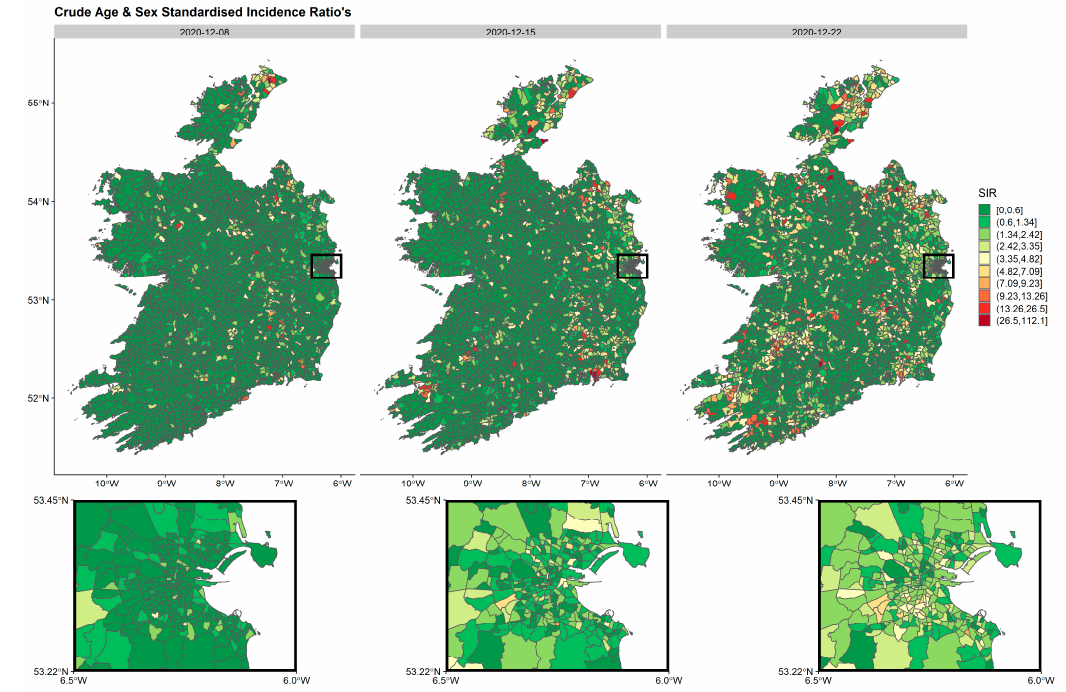
Figure 2. Age- and sex-standardised incidence ratios’ (SIRs) by week per ED in Ireland during the first three weeks of wave 3 (8 December 2020–22 December 2020). The inset represents the greater Dublin area (capital of Ireland), where EDs are generally smaller in geographical size due to larger populations. The maps are standardised to the whole pandemic.